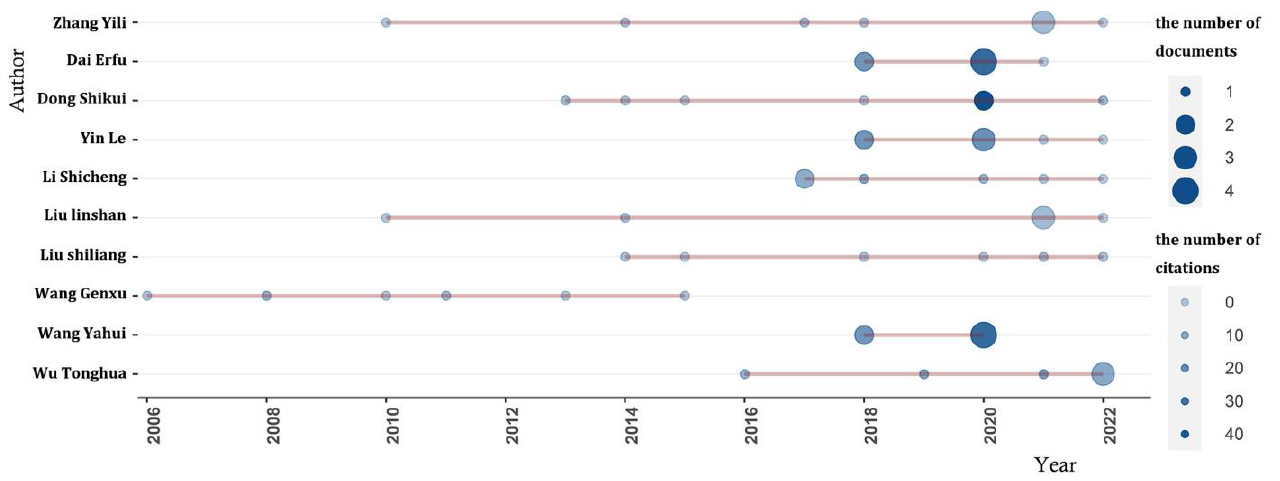
Figure 5. Authors’ production over time on the topic of the ecological and environmental effects of land use and cover changes (LUCC) on the Qinghai-Tibetan Plateau (QTP). Note: the size of the circle represents the number of documents, and the shade of the color represents the number of citations.